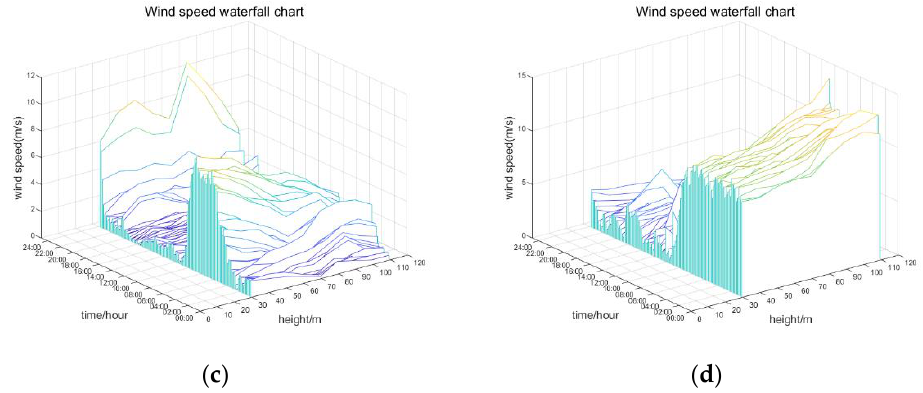
Figure 10. Wind speed waterfall diagram: ( a ) 14 November 2017 (autumn); ( b ) 27 February 2018